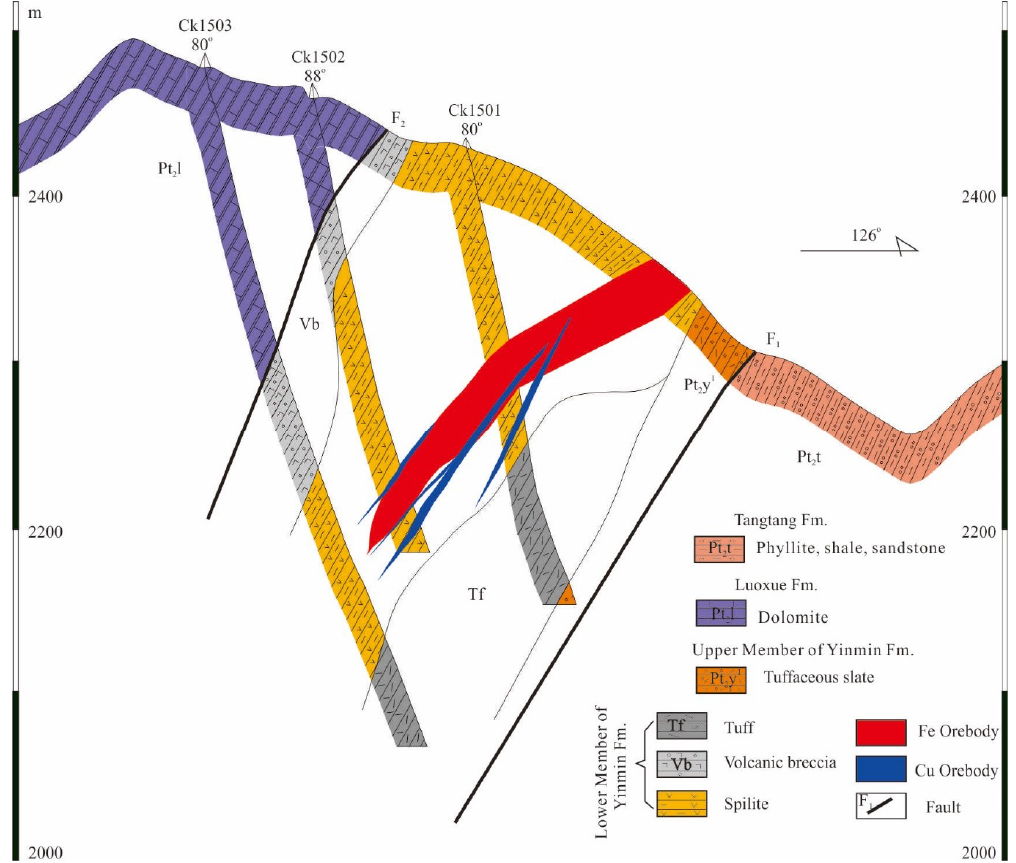
Figure 5. Geological cross-section of the Xianglushan Fe-Cu